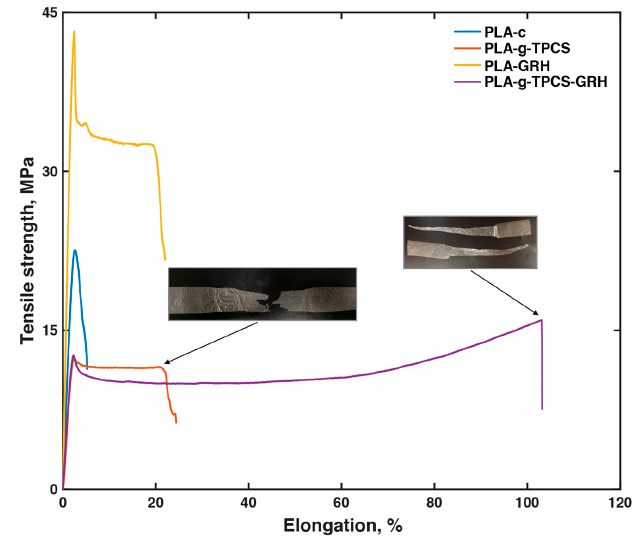
Figure 3. Tensile strength vs elongation at break for films produced by twin-screw extrusion–cast-film extrusion.